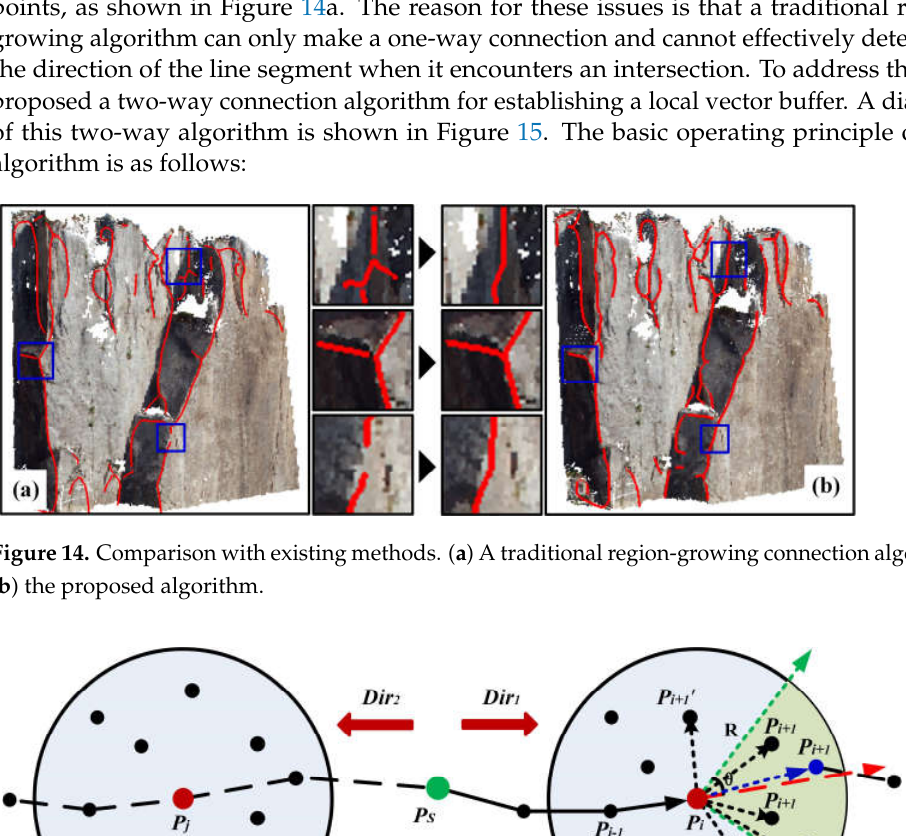
Figure 13. Diagram of the normalized smoothing process of the local straight line of the potential discontinuity trace points (the black points and red points are the points before smoothing, and the blue points are the points after smoothing).